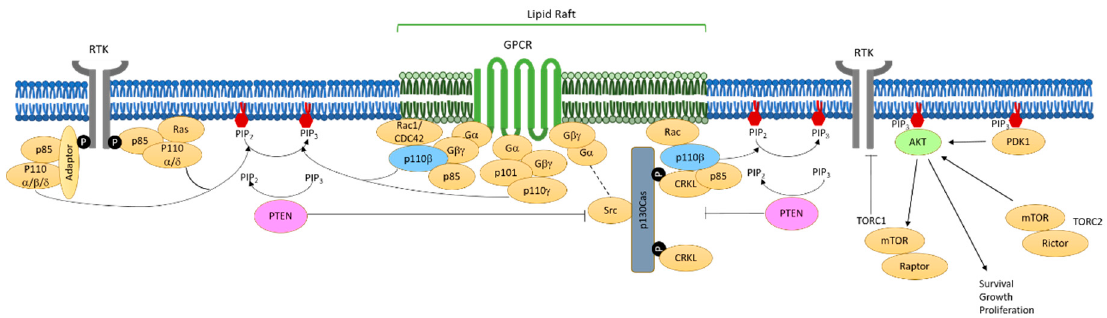
Figure 1. Overview of PI3K-AKT signaling pathway. Class I PI3Ks are heterodimers composed of a catalytic subunit (p110) and a regulatory subunit (p85 or p101). Once activated by cell surface receptors, PI3Ks phosphorylate PIP 2 to PIP 3 , which activates AKT for cell survival, growth, and proliferation. PTEN is the main negative regulator of the signaling pathway. PTEN-null tumor cells often rely on p110b for PI3K signaling, and the figure above depicts the potential mechanism of p110b activation via CRKL / p130Cas / Src / Rac, which results in their localization in lipid rafts in the absence of PTEN.